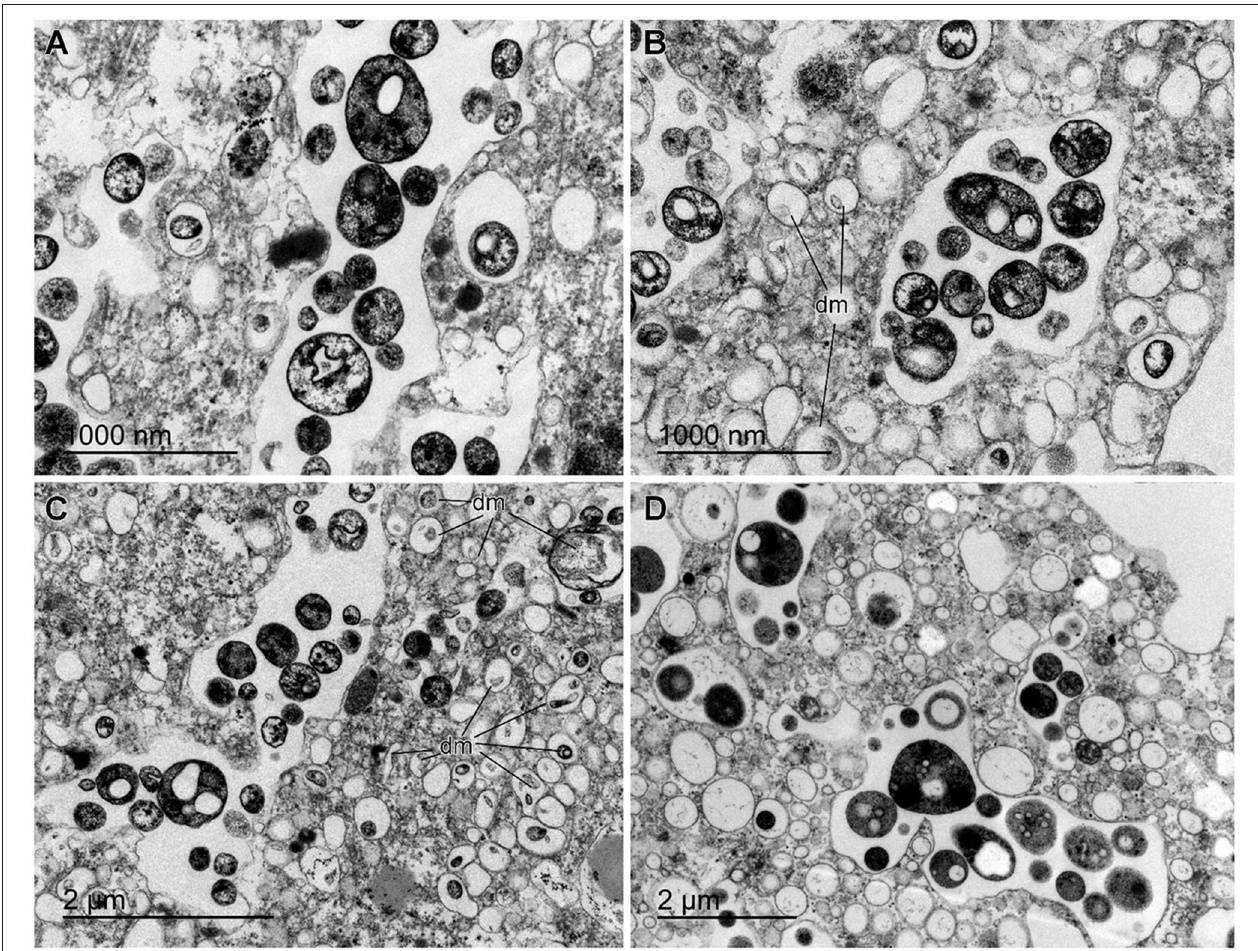
FIGURE 10 | Details of bacteria in the bacteriosyncytia of Vazella pourtalesii . (A–D) Diversity of intracellular microbes hosted in either individualized or collective membrane-bound vesicles. Coccoid cell shapes predominate, typically characterized by one or several granules and inclusions. Documented microbial sizes rarely exceed 0.8 µ m in the largest diameter. Some of the microbes appear to be degraded or digested within the vesicles